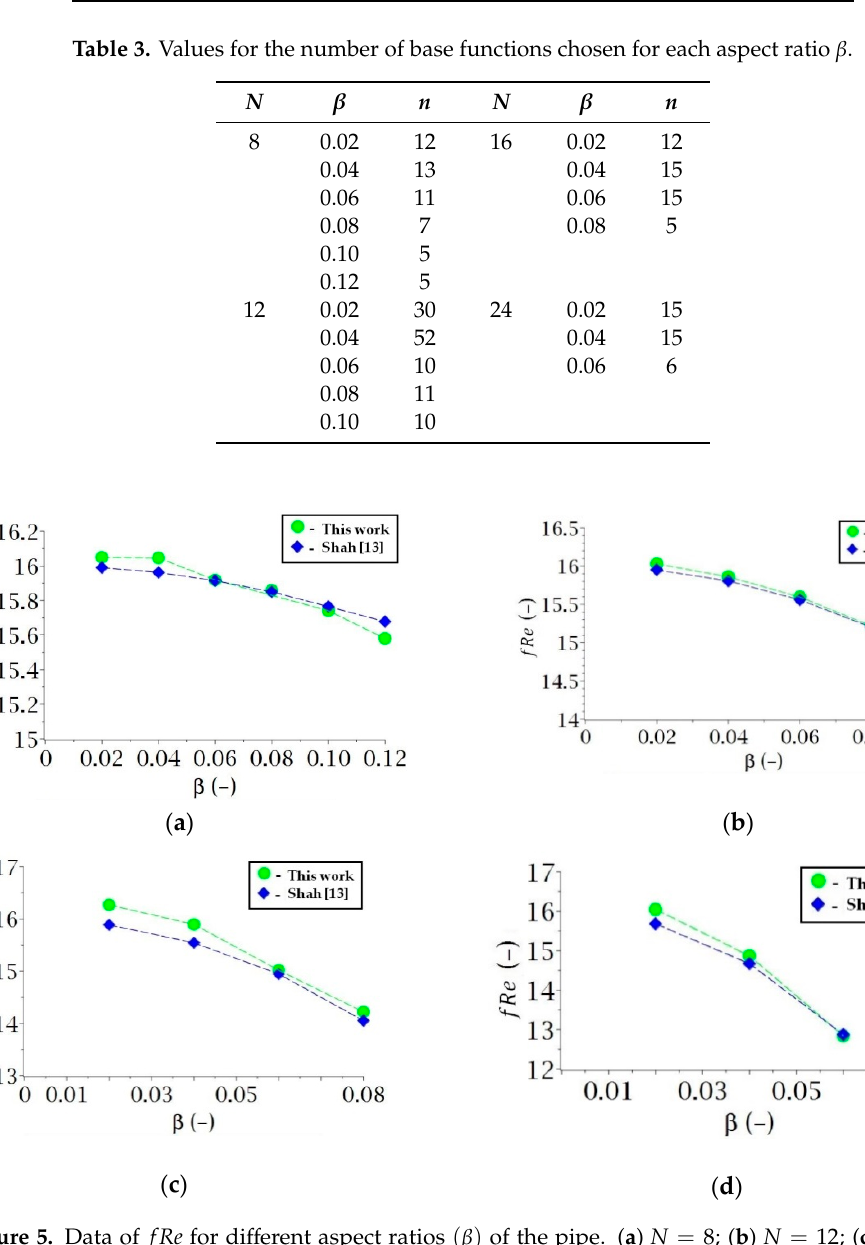
Figure 5. Data of fRe for di ff erent aspect ratios ( β ) of the pipe. ( a ) N = 8; ( b ) N = 12; ( c ) N = 16; Figure 5. Data of 𝑓𝑅𝑒 for different aspect ratios (𝛽) of the pipe. ( a ) 𝑁 = 8 ; ( b ) 𝑁 = 12 ; (c) 𝑁 = ( d ) N = 16 ; ( d ) 𝑁 = 24 .